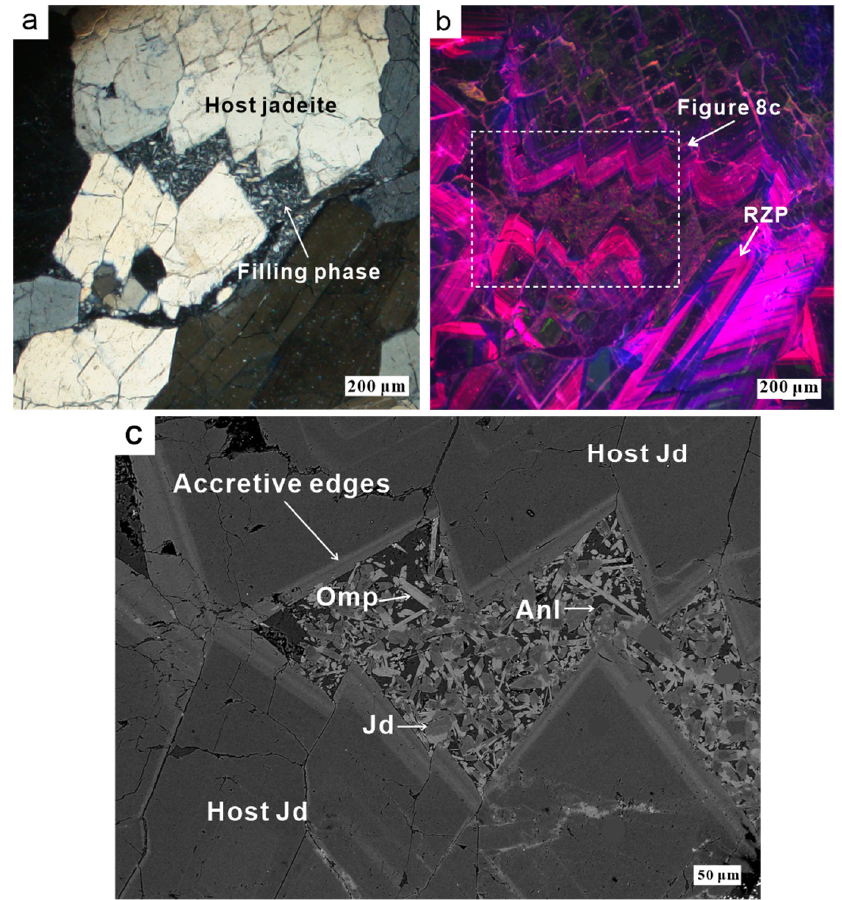
Figure 8. ( a ) In Type II MTDs, the surrounding host grains show mainly primary texture in which dynamic metamorphism and recrystallization cannot be observed with 10 × magnification under cross-polarized light. ( b ) The cathodoluminescence picture of ( a ) shows visible rhythmic zoning patterns inside the host grains. ( c ) The BSE image of the part of ( a ) shows clearly overgrowths on the outlines of host grains and the relationship between the filling jadeite, omphacite, and analcime in Type II interstitial textures (Jd—Jadeite, Omp—Omphacite, and Anl—Analcime). In both types of MTDs, many host jadeite crystals have overgrowths with wide widths from 5.0 to 65 µm across (Figures 7c and 8c). The overgrowths appear similar in brightness to the fi lling jadeite under the BSE images and grow along the outlines of host